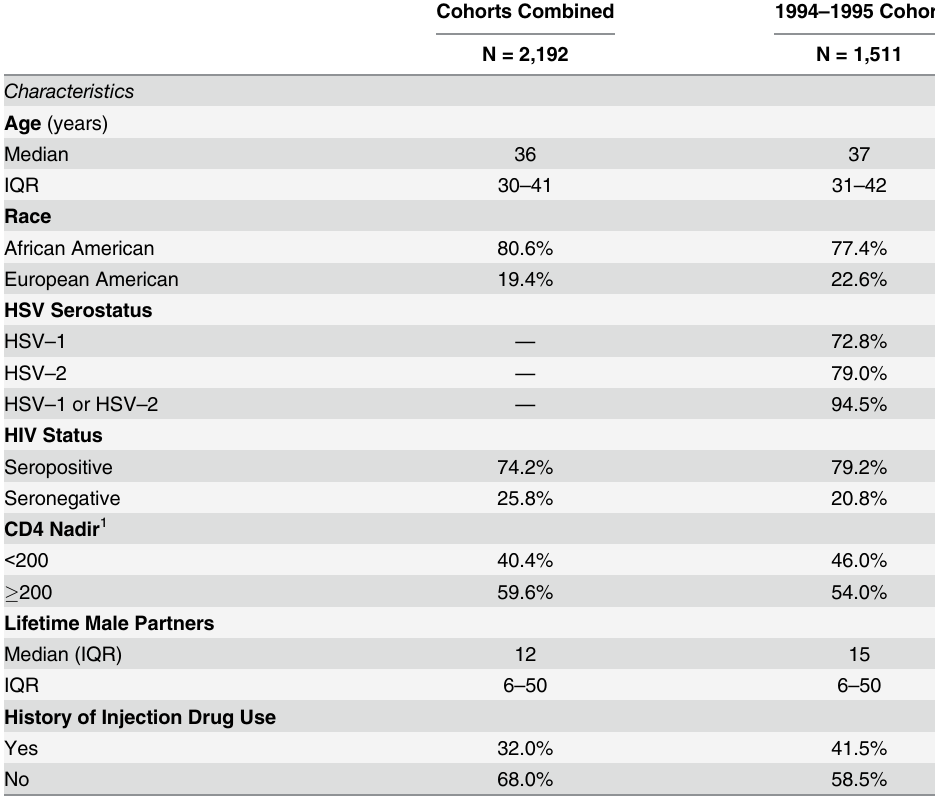
Table 1. Participant characteristics at